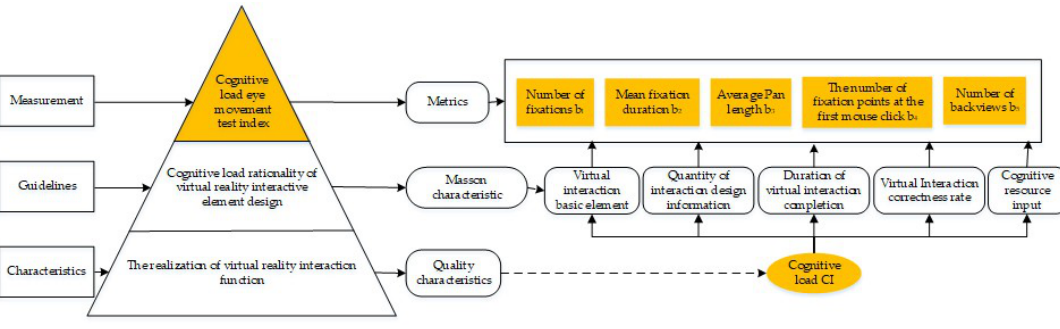
Figure 2. Eye movement assessment model of cognitive load in a virtual reality system.